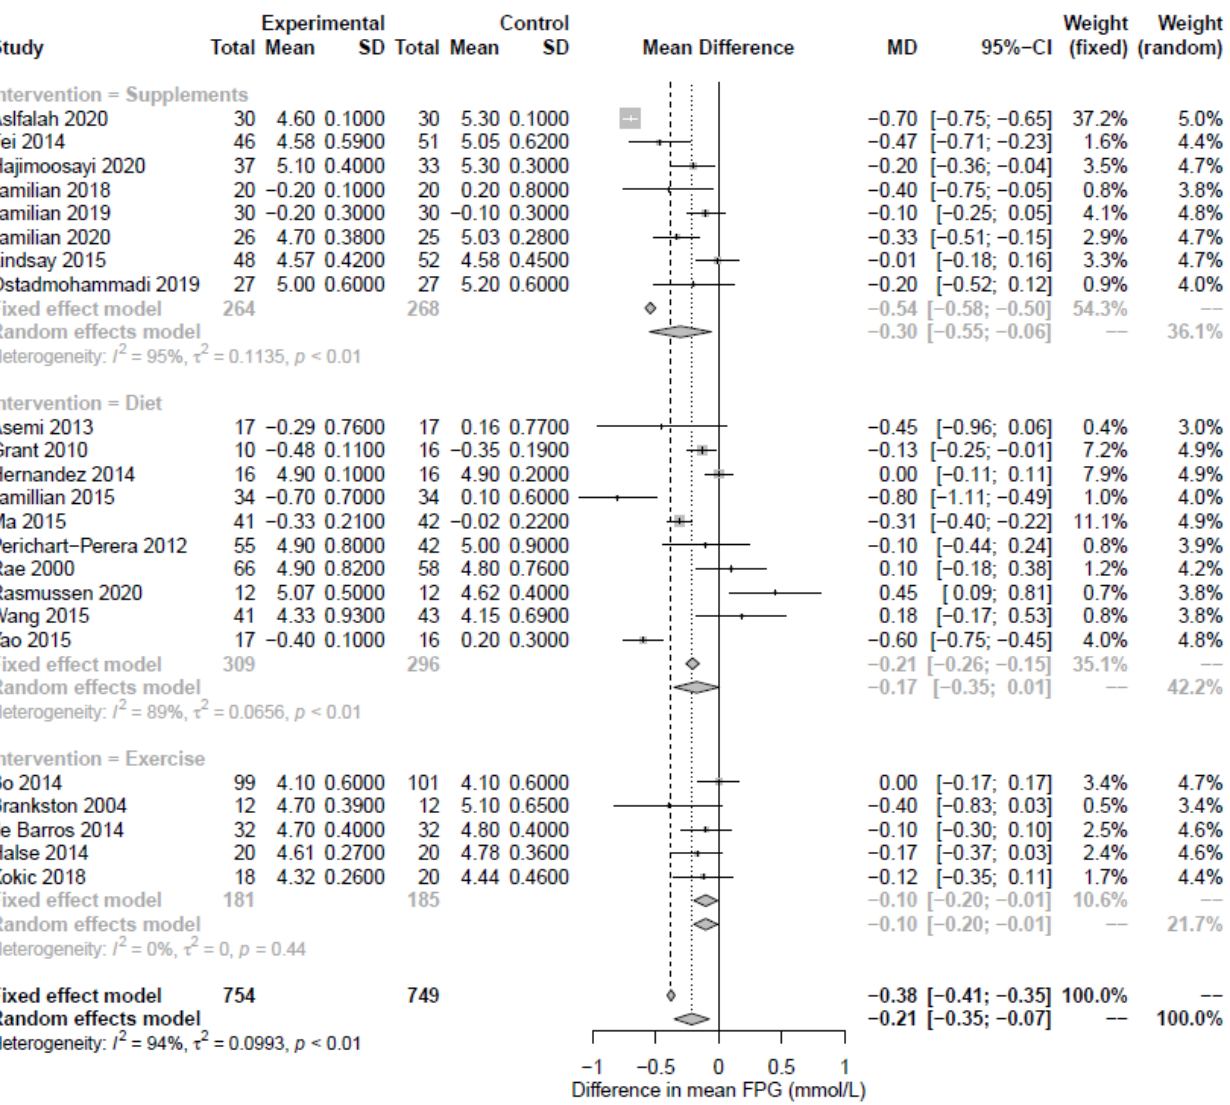
Figure 2. Forest plot of fasting plasma glucose (mmol/L). Fixed and random-effect meta-analysis of included studies. Overall test for effect of any lifestyle intervention (with all studies; n = 23) and subgroup analysis by intervention type — nutritional supplements (n = 8), diet (n = 10), and exercise (n = 5) — are presented. SD, standard deviation; CI, confidence interval.